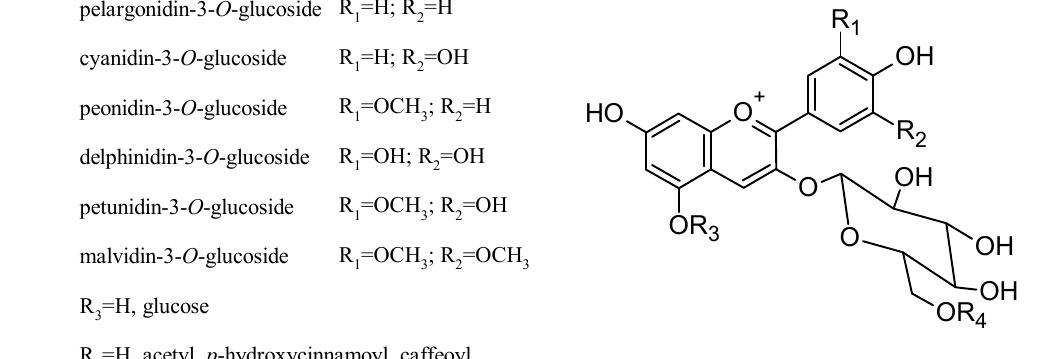
Figure 3. Structures of the principal V. vinifera grape anthocyanins.